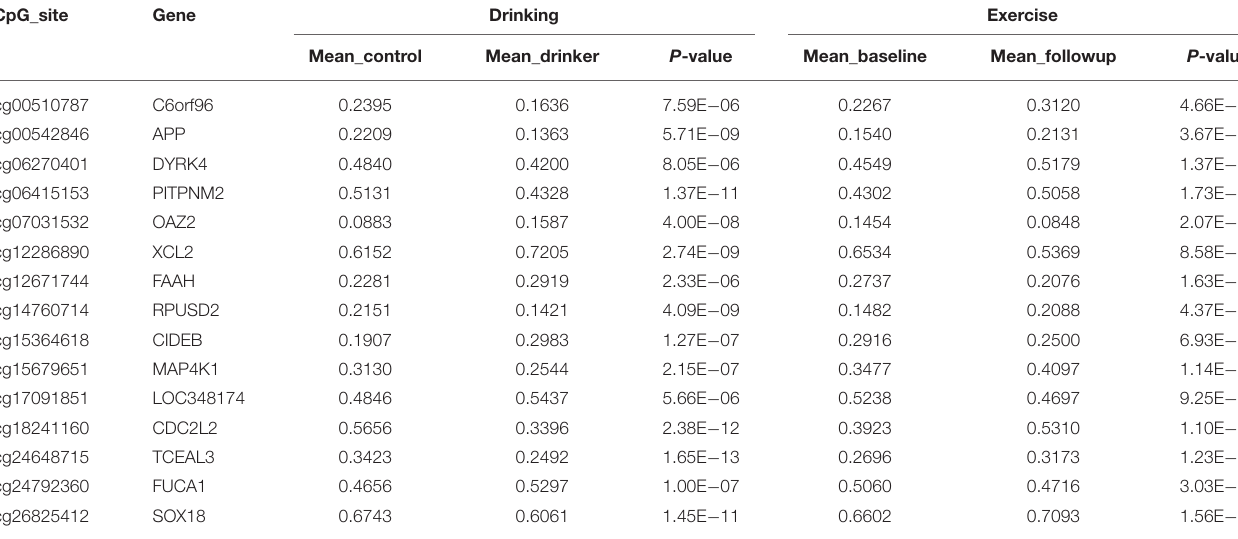
TABLE 3 | CpG sites identified to show opposite directions of significant alterations between exercise and alcohol use. CpG_site